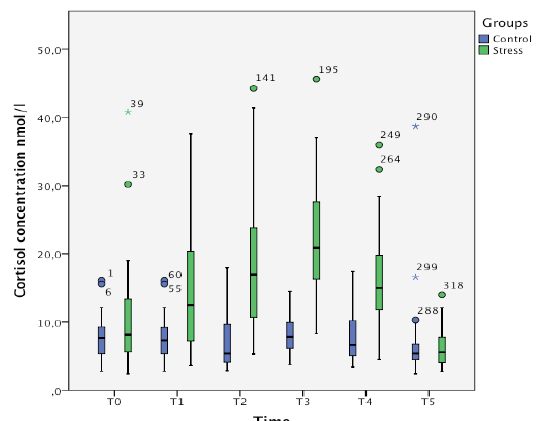
Figure 3. Saliva cortisol levels in subjects of the stress and resting control conditions assessed immediately after the public speaking task (T1) and immediately (T2), 10 (T3), 30 (T4) and 120 (T5) minutes after tooth brushing (collapsed stress vs. resting control